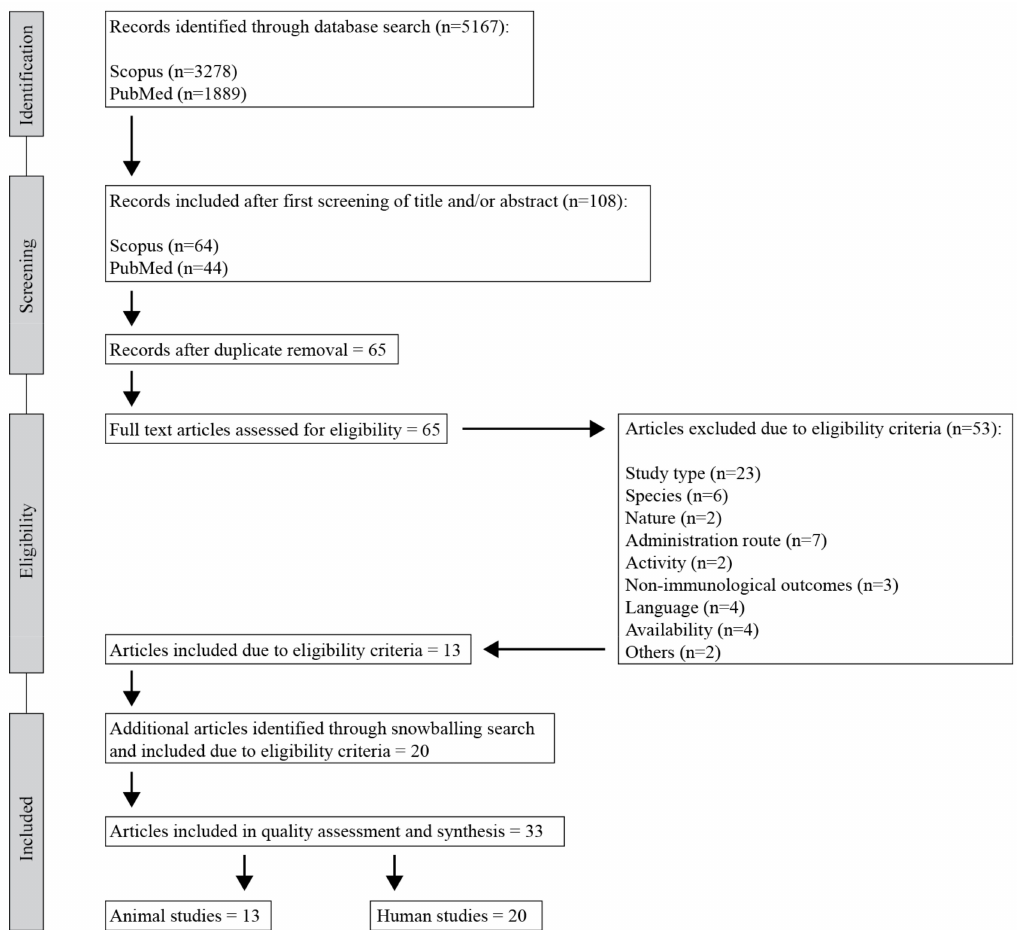
Figure 1. Flowchart of study selection process (following PRISMA